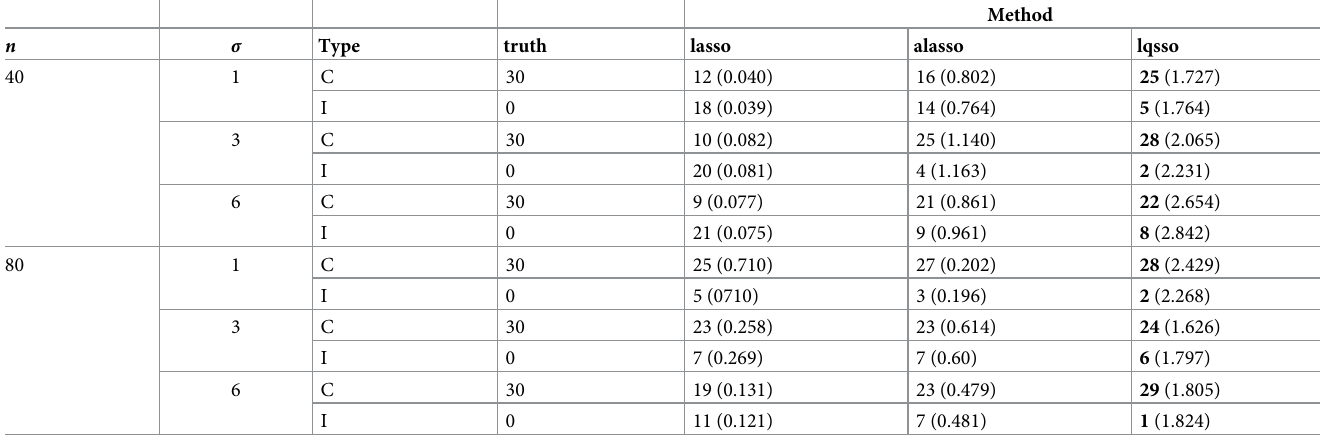
upon simulation studies outlined formerly in this section. It should be pointed out that the row labeled C shows the number of correctly identified non-zero variables, and the row labeled I indicates the number of zero variables incorrectly selected by each method. Hence, the method with high and less values for C and I , respectively, is preferred. Table 5. Median of the number of (in)correctly selected variables for Model